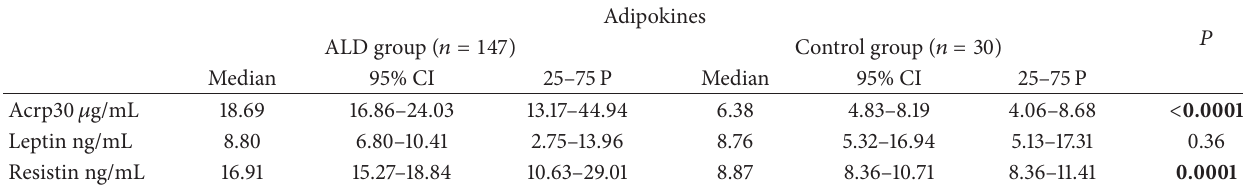
Table 3: Comparison of serum adipokine levels in ALD patients and the control group ∗ .